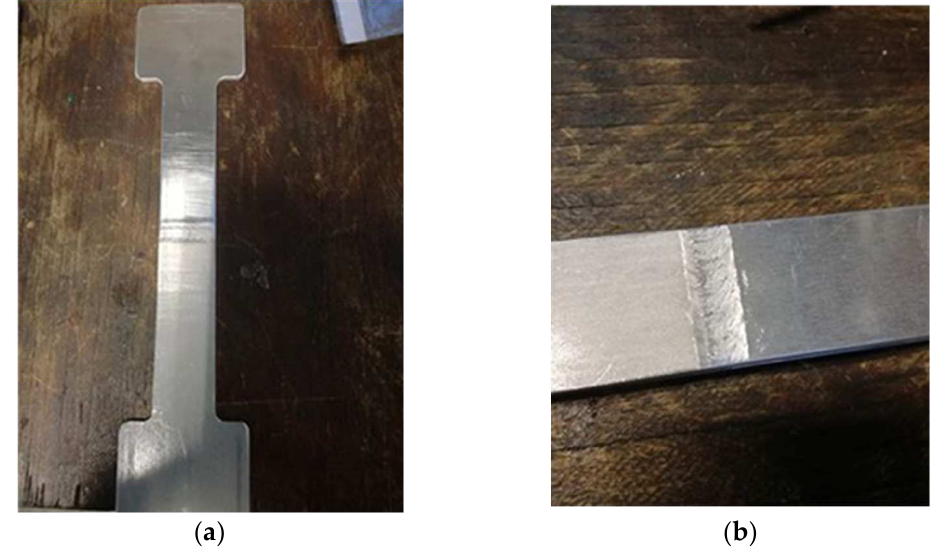
Figure 7. ( a , b ) Pictures of specimens prepared for tensile testing.